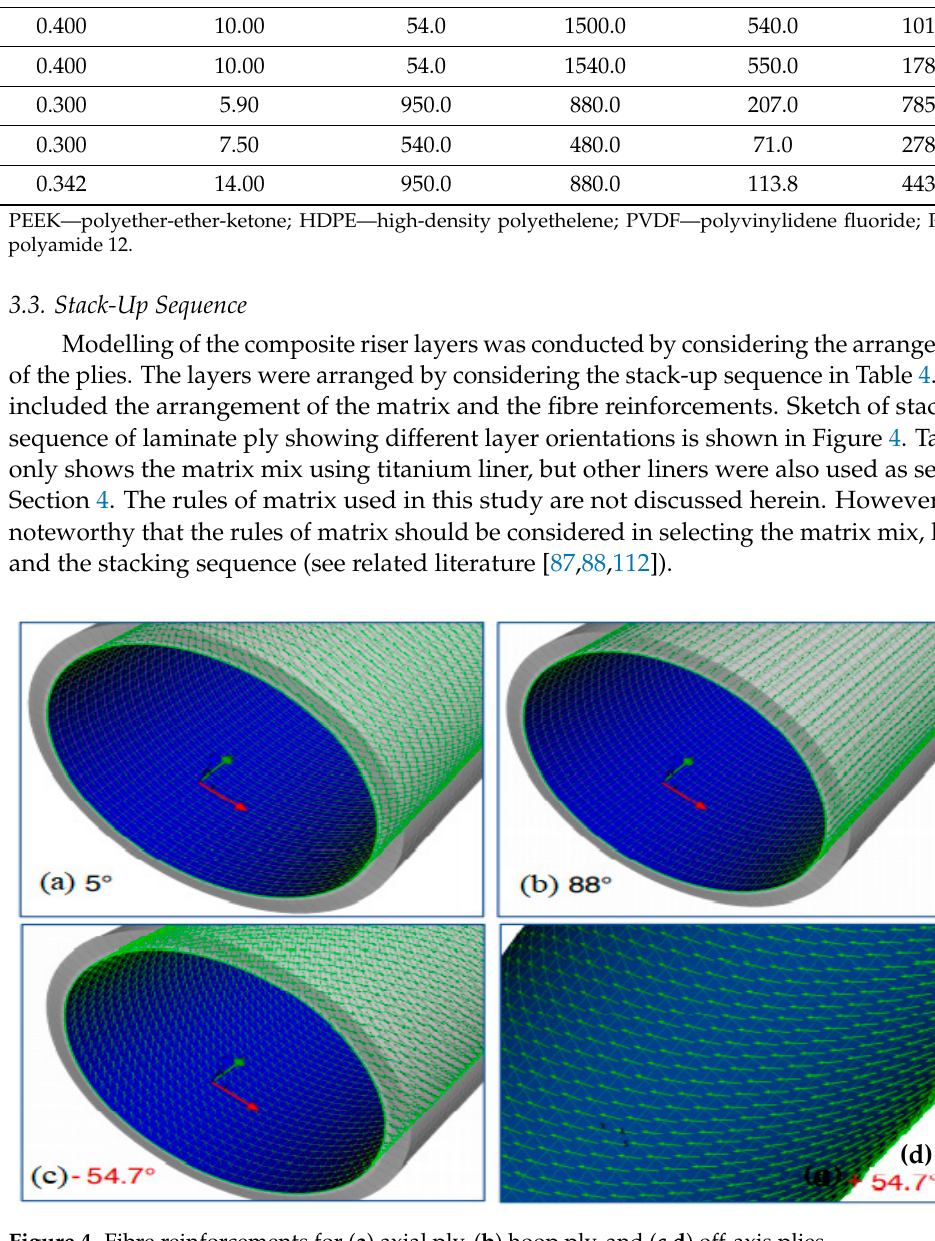
Table 3. Material characteristics for liners.